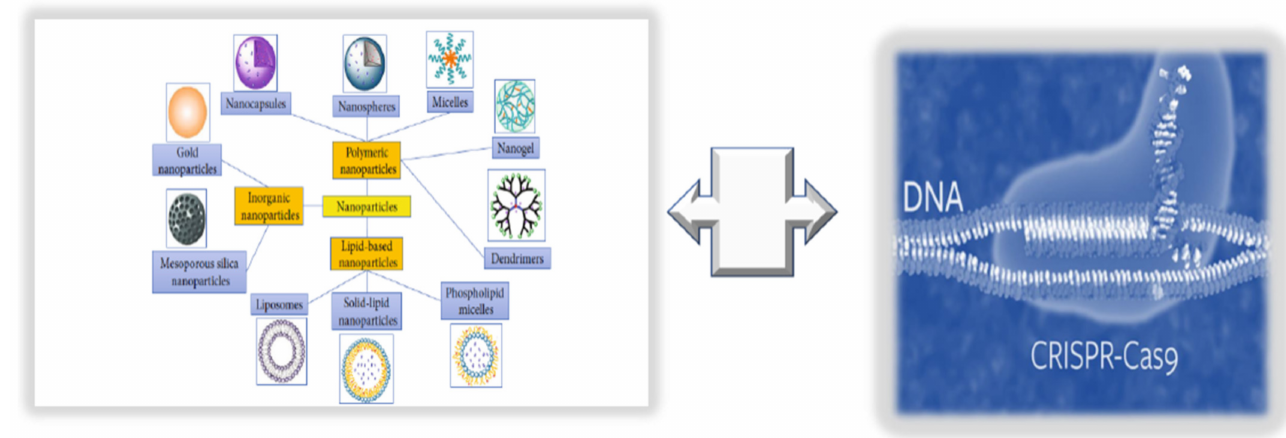
Figure 6. Innovative technologies for targeted endothelium treatments: nanomedicine + CRISPR/ Cas9